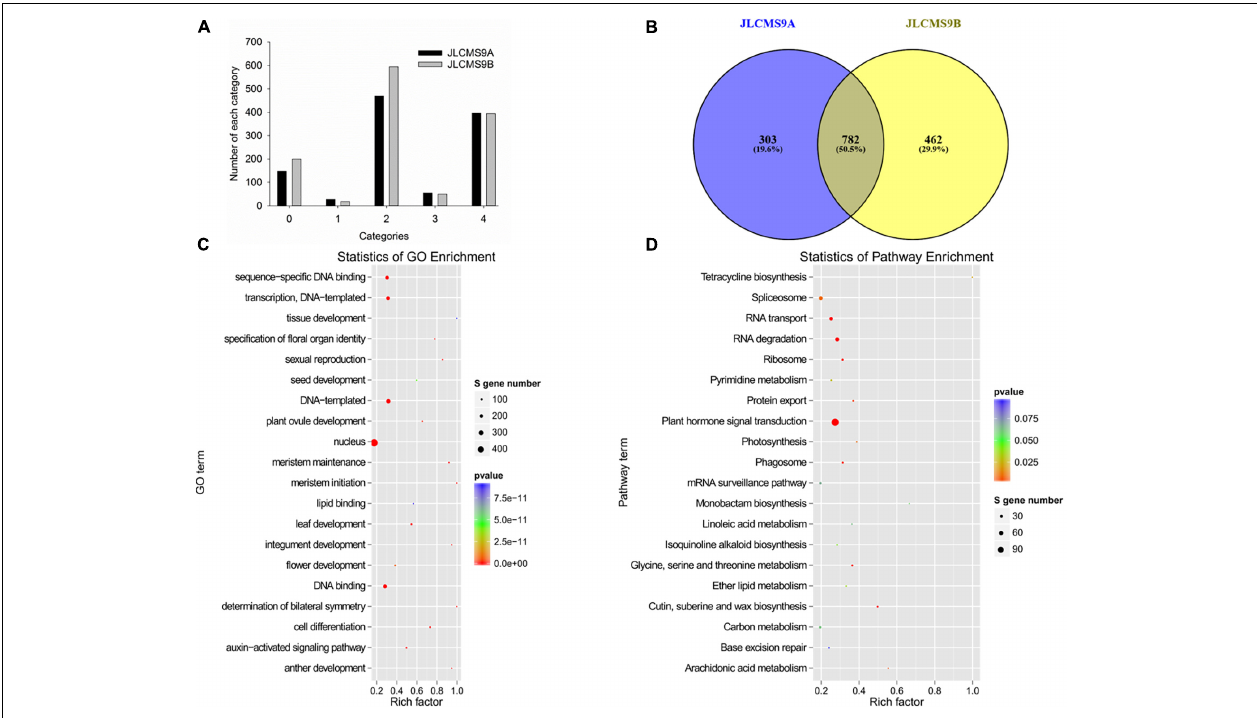
FIGURE 3 | The profiles of small RNAs (sRNAs) and target genes in JLCMS9A and JLCMS9B. (A) Number of sRNAs in different categories. (B) Number of unique and common sRNAs in JLCMS9A and JLCMS9B. (C) Gene Ontology (GO) functional analysis of target genes. (D) Kyoto Encyclopedia of Genes and Genomes (KEGG) pathway analysis of target